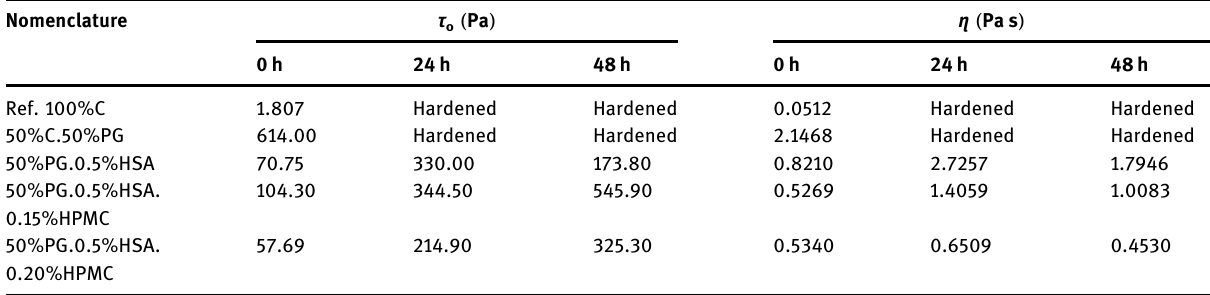
Table 6: Rheological